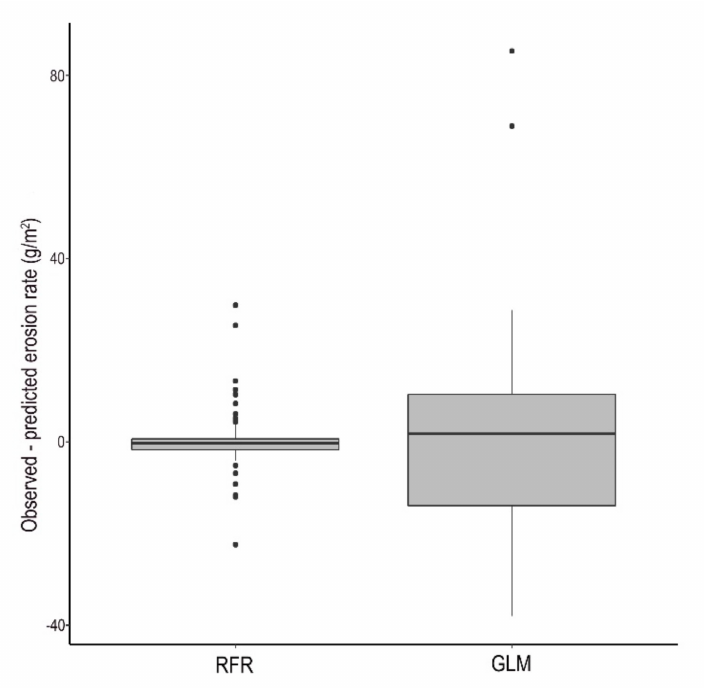
Figure 10. Di ff erences of observed and modelled erosion by random forest regression (RFR) and general linear model